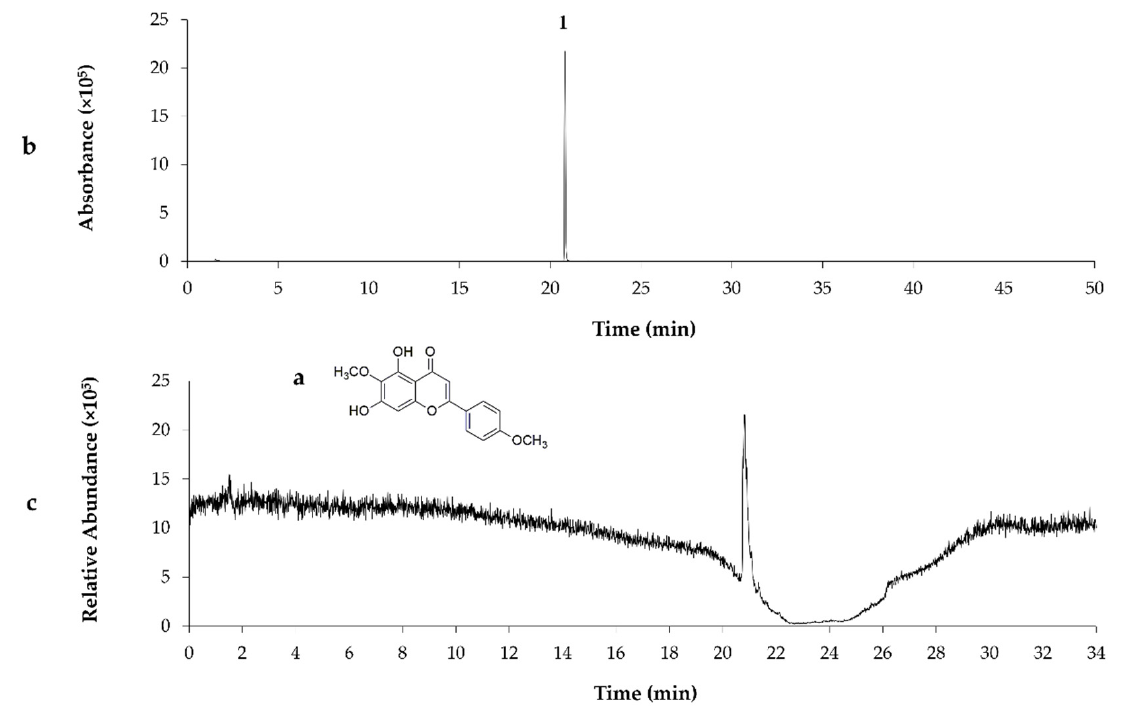
Figure 2. The chemical structure of pectolinarigenin ( a ); LC-MC chromatogram of P1 isolated from G18.EE-EtOAc fraction using ESI ( b ); TIC chromatogram in negative ion mode ( c ); Pectolinarigenin ( 1 ).